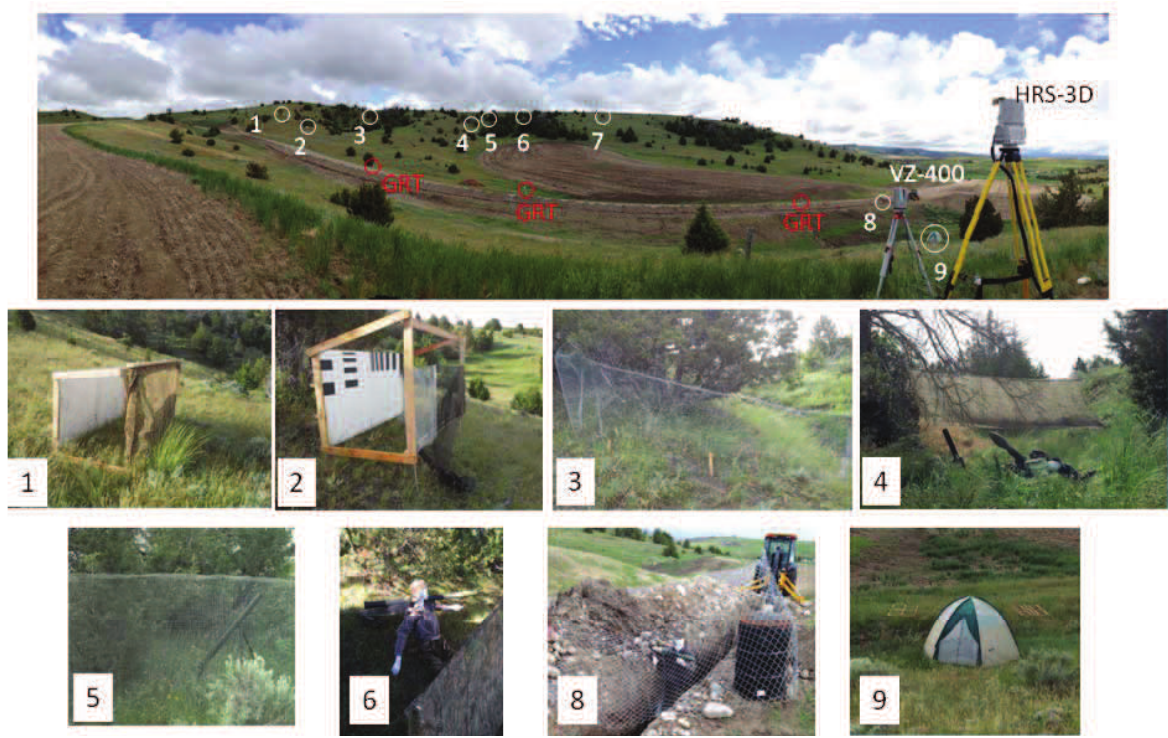
Figure 1: (Top) Overview of scan area and target placements (Middle and bottom rows) Images of targets [No image of target 7 available]